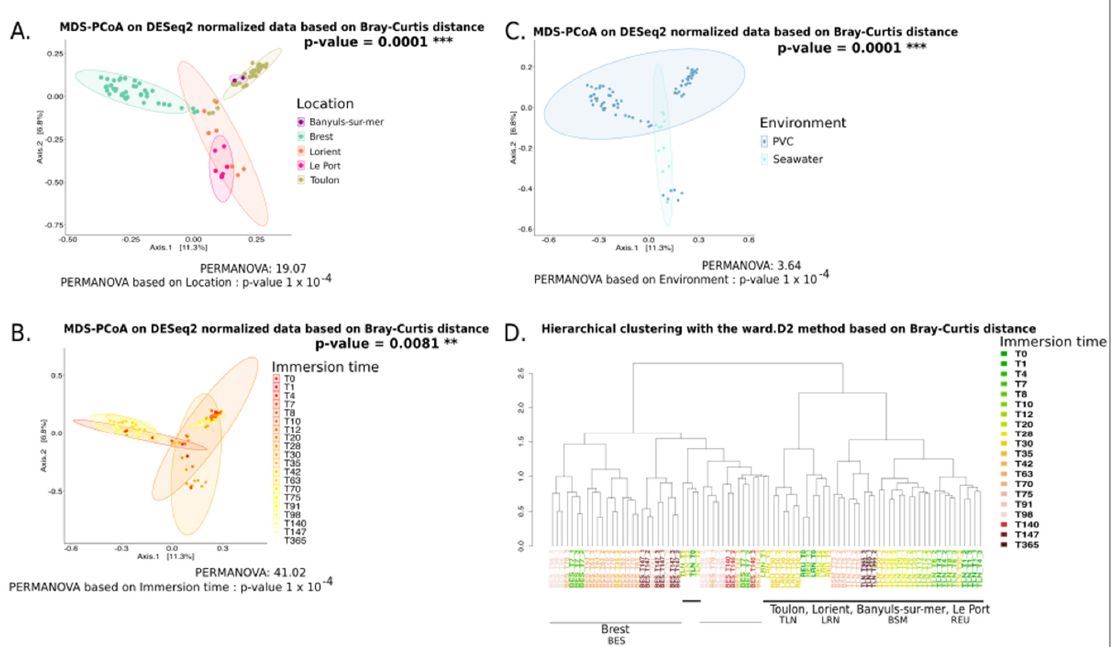
Figure 3. Principal Coordinate Analysis (PCoA) of the similarity in fungal community composition, based on the ITS2 dataset, showing the relationship between the variables “Location” ( A ), “Immersion time” (days), ( B ) and “Environment” ( C ), and the signi fi cance of each variable. ( D ) Hierarchical clustering of the samples based on the variable “Incubation time”.”**” and “***” represent a highly and a very highly signi fi cant in fl uence of the evaluated factor, respectively. The PCoA was generated using Bray–Curtis dissimilarity as the distance measure, with each point representing a sample. Ellipses connect groups of samples that were subjected to the same conditions.